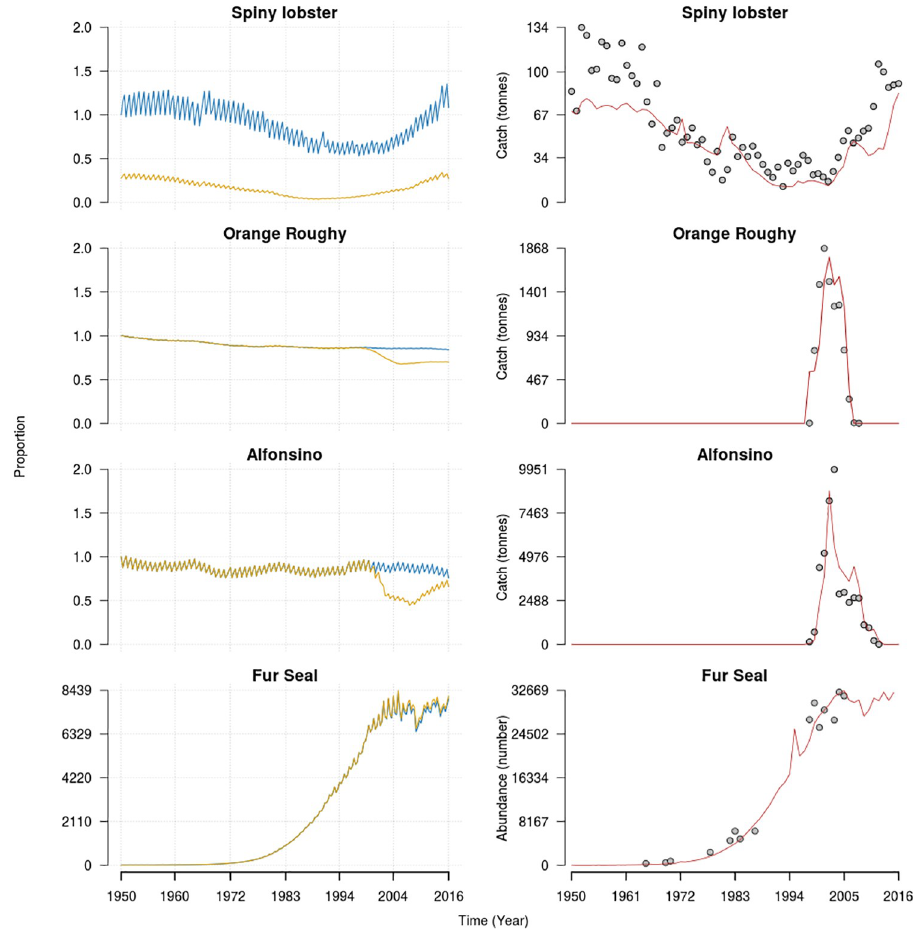
Fig 3. In the left column are presented the time series of the biomass relative to the initial biomass of an unfished (blue line) and fished (yellow line) ecosystem. The first three rows of the right column represents the time series of simulated catches in Atlantis (red line) and observed (gray dots). For the Fur seal, the dots represented the observed abundance and the red line is the estimated abundance from Atlantis.